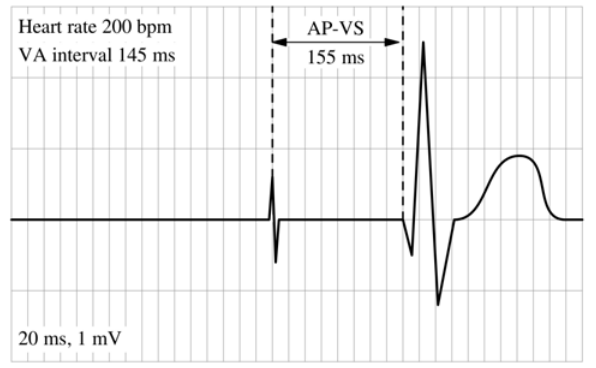
Fig 4. The MetaPost AP-VS-Visualizer. A short software script utilizes the patient´s heart rate (JET simulator rate) and the AV delay as adjusted by the tester to calculate and graphically to display the interval between atrial pacing and sensing of the subsequent QRS complex. AP: atrial pacing, VS: ventricular sensing, AV: atrioventricular, bpm: beats per minute, ms: milliseconds, mV: